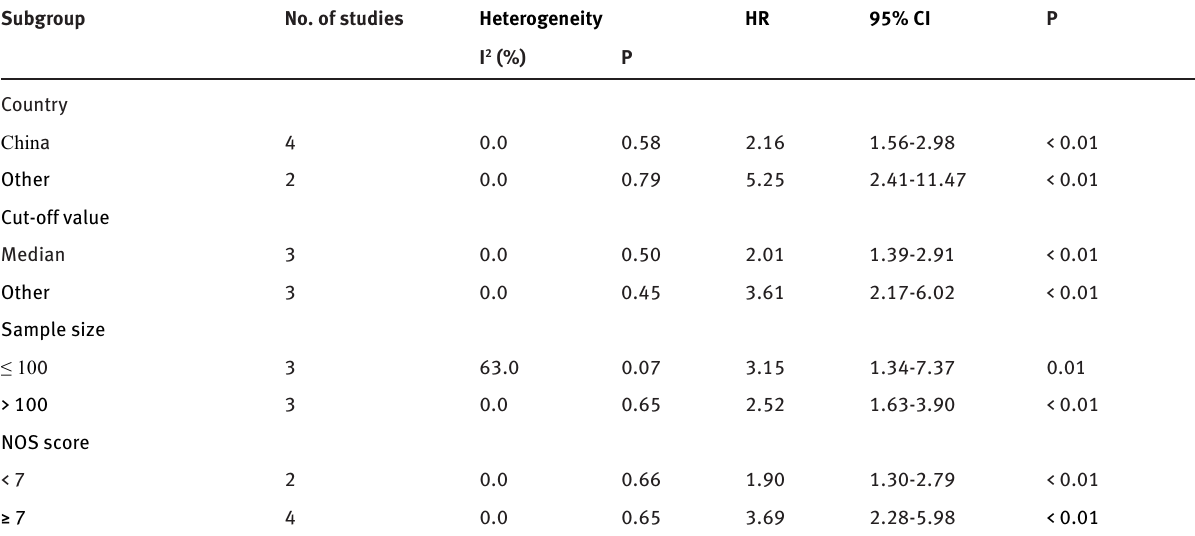
Table 2: Subgroup analysis of association between HOTAIR expression and OS in CRC.